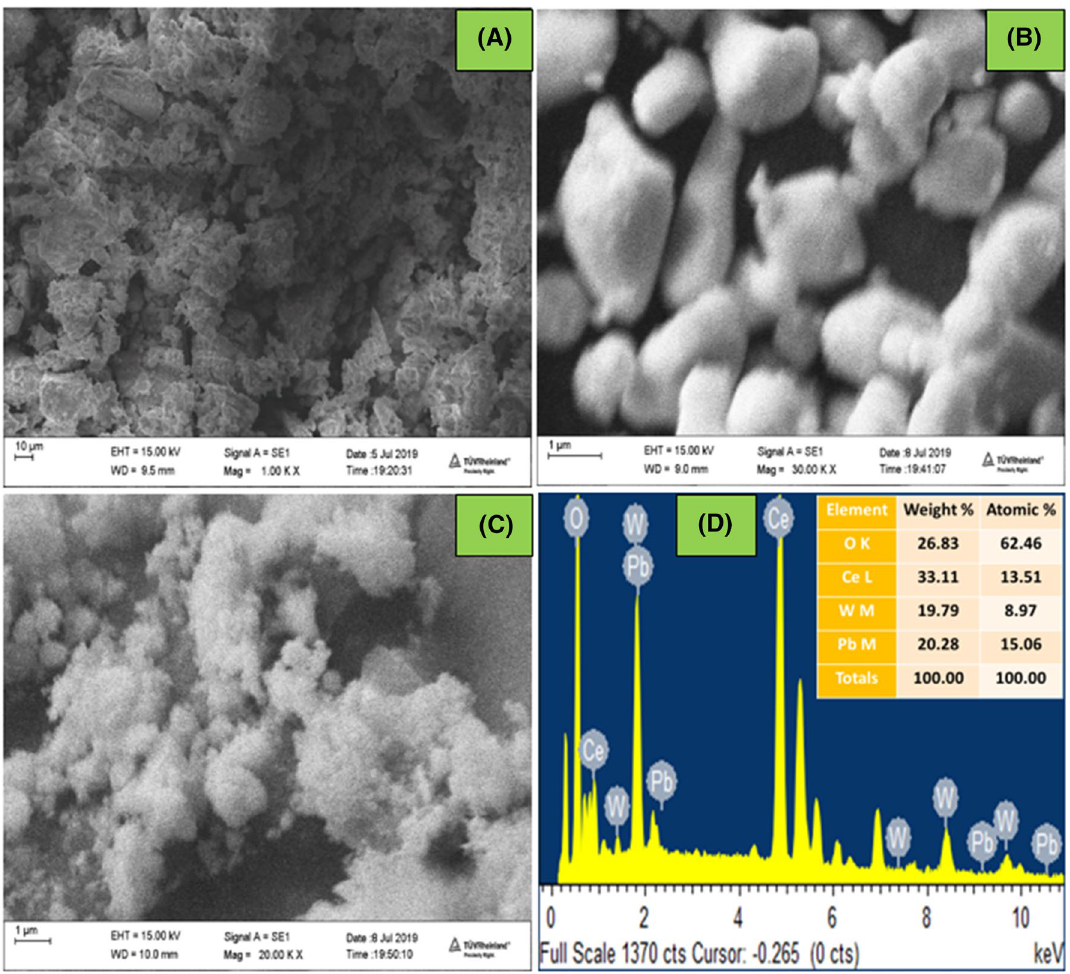
Fig. 3 HRSEM micrographs of as-synthesized a CeO 2 b PbWO 4 c CeO 2 /PbWO 4 NCs and d EDX spectrum of the CeO 2 /PbWO 4